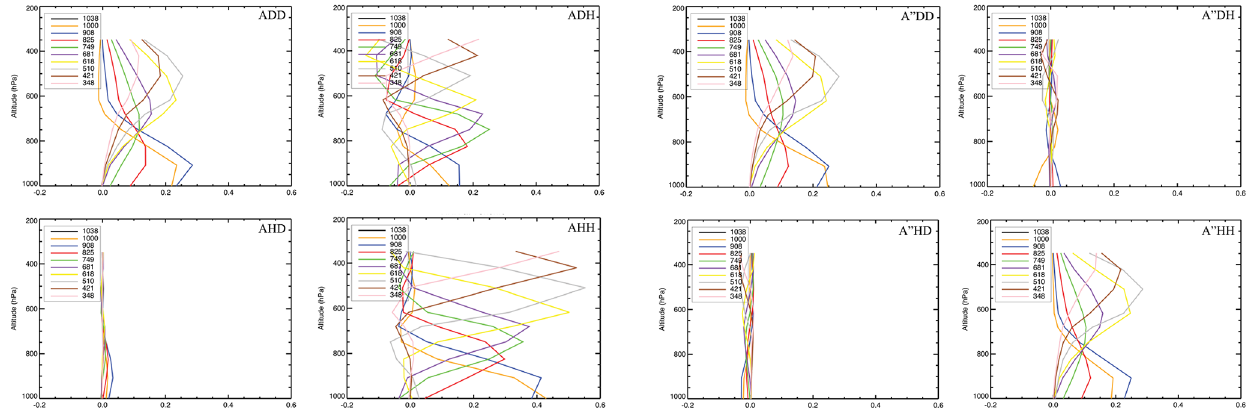
Figure A1. Averaging kernels in the (ln[H 2 O], ln[HDO]) basis for A DD , A DH , A HD , and A HH , and in the ((ln[H 2 O]+ln[H 2 O])/2, ln[HDO]- ln[H 2 O])-proxy state after a posteriori correction ( A (cid:48)(cid:48)